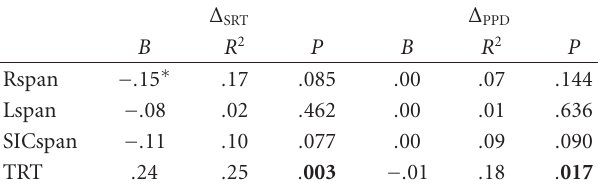
Table 4: Associations ( P < . 05) between the dependent variables